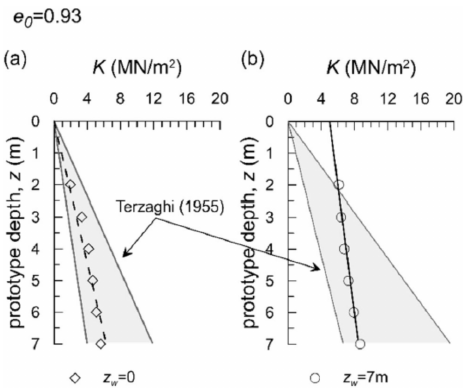
Figure 13. Profiles with depth of the initial stiffness, K , of the p-y curves predicted versus literature solution: ( a ) saturated conditions (LS), ( b ) partially saturated conditions